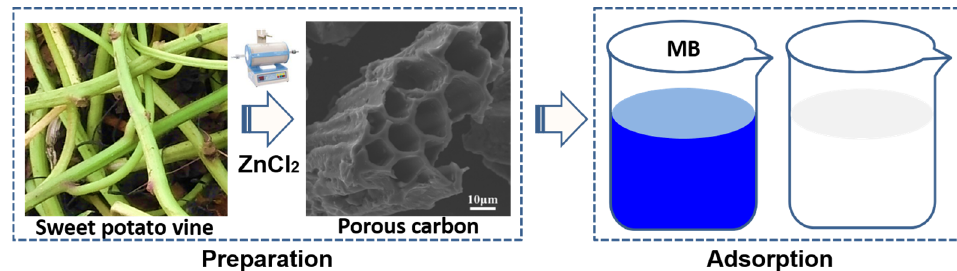
Figure 1. Schematic representation of the preparation and adsorption of SPVPC.